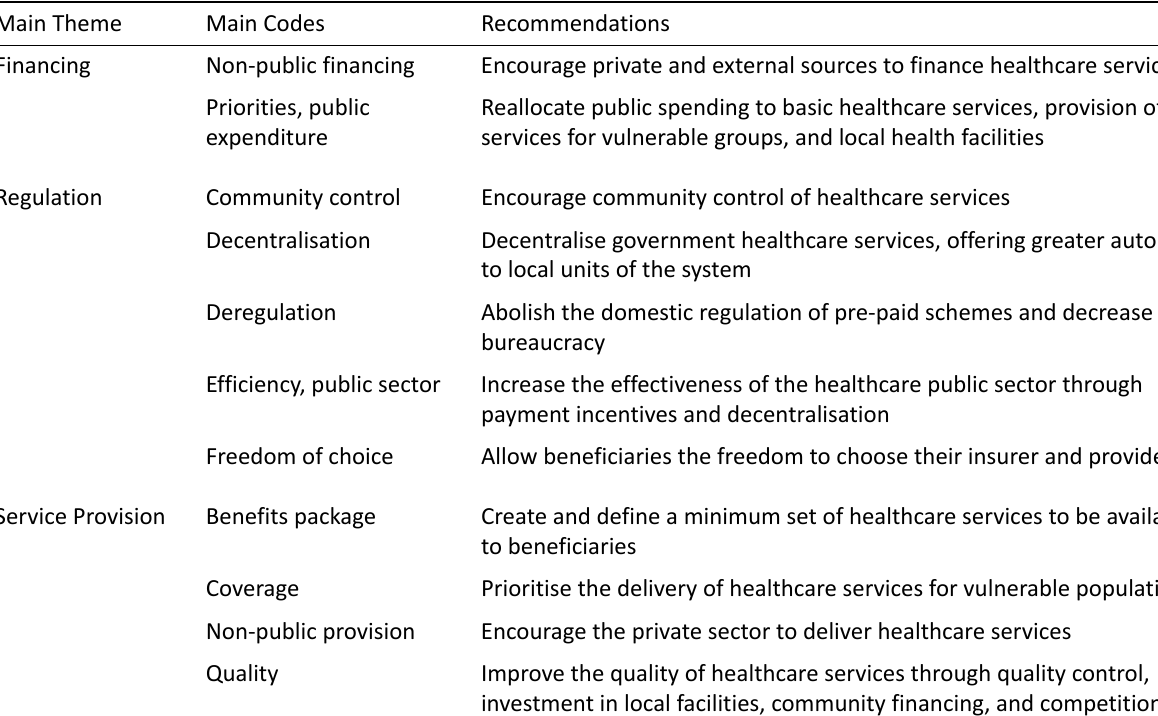
Table 3. Simplified codebook.